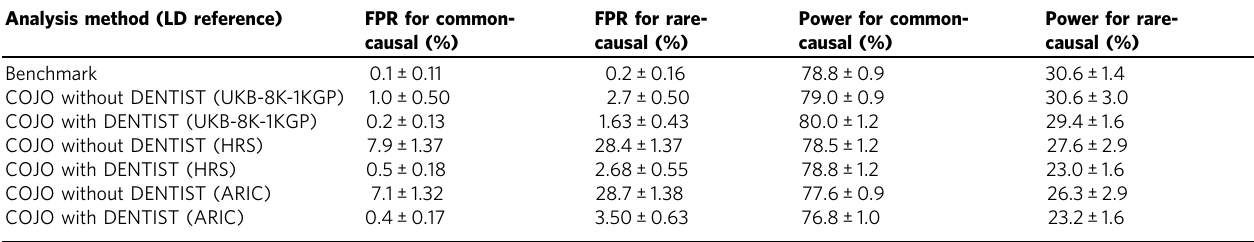
Table 2 FPR and power of COJO before and after DENTIST-based QC in simulations. Analysis method (LD reference) FPR for common-